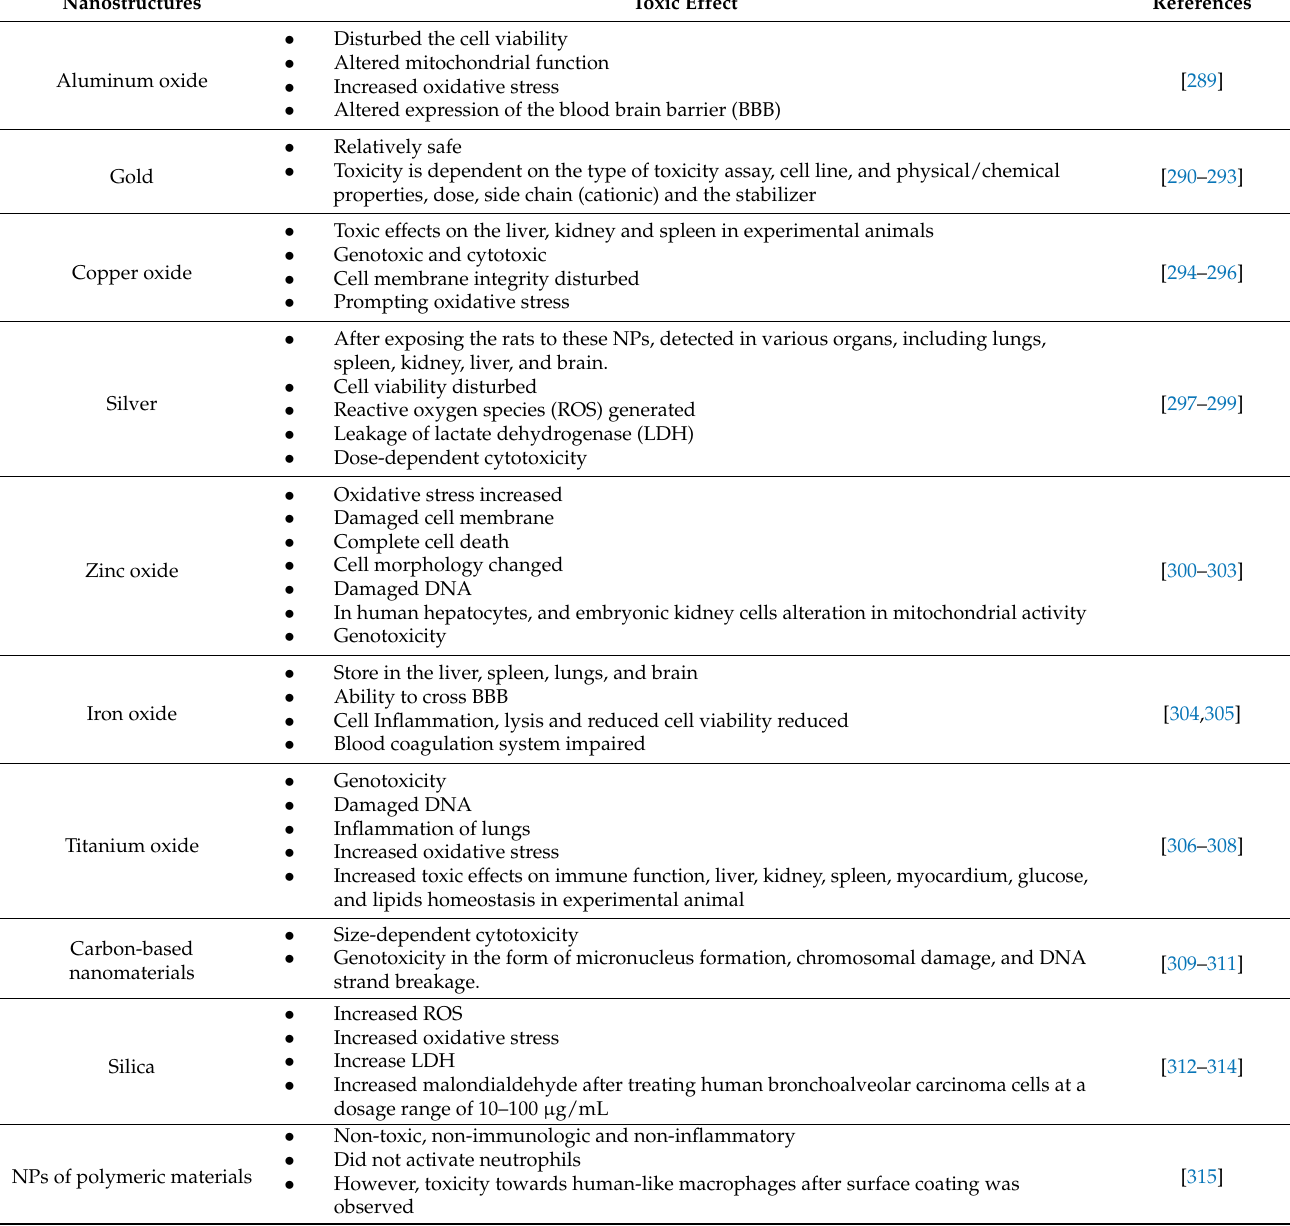
Table 5. Toxic effects of various nanostructures used in